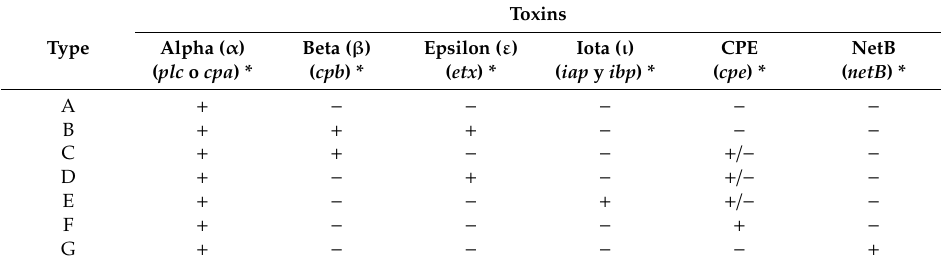
Table 1. Types of Clostridium perfringens according to the toxins produced and the genes that encode the